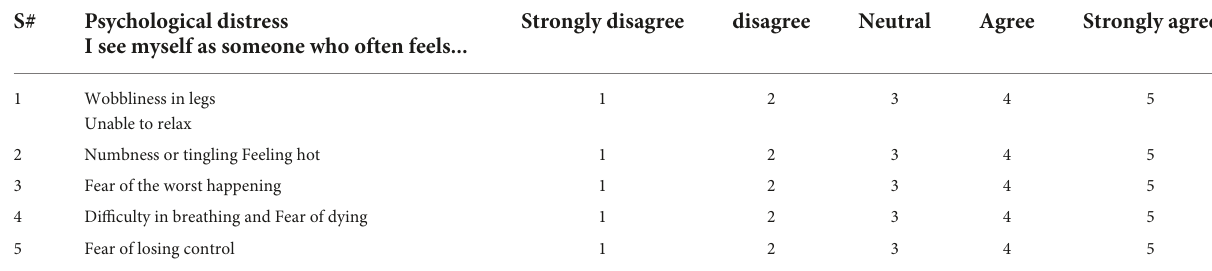
Strongly disagree